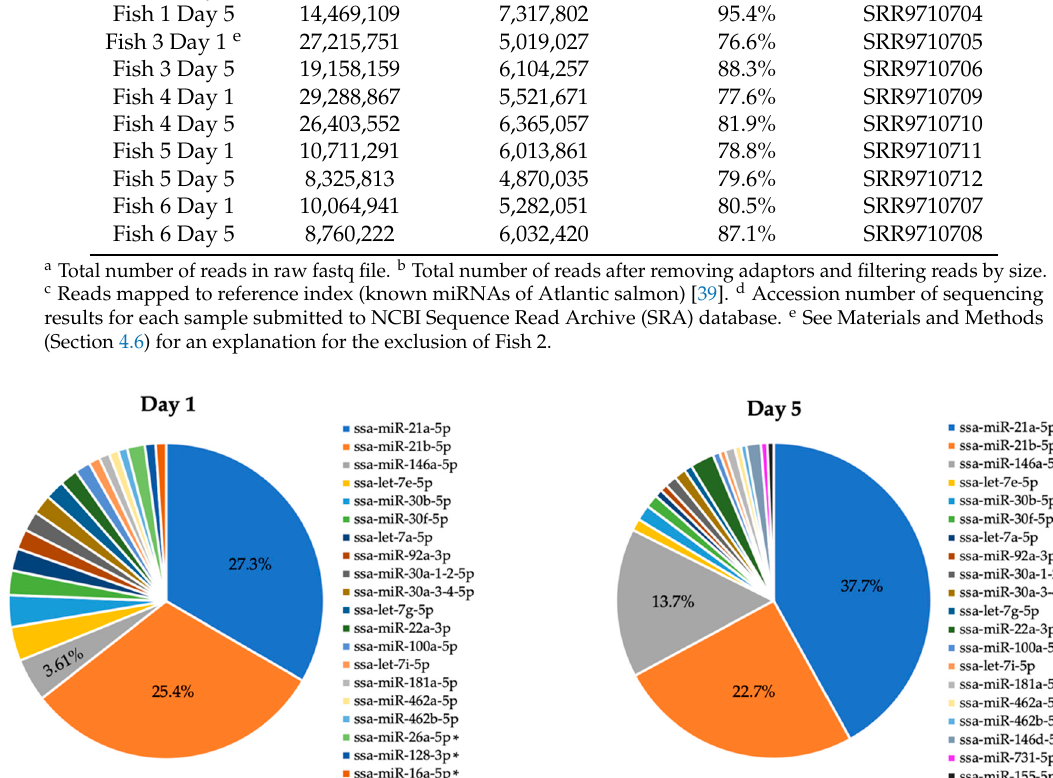
Table 1. Sequencing results.